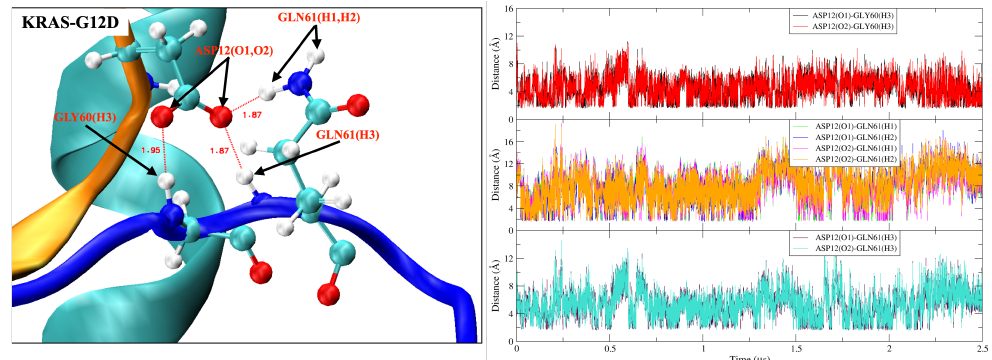
Figure A5. Hydrogen bond interactions between KRAS-G12D ASP12 residue and amino acid residues (GLY60, GLN61) of SW-II domain. ( Left ) Representative snapshot of HB ASP 12 ( O 1/ O 2 ) − GLY 60 ( H 3 ) , HB ASP 12 ( O 1/ O 2 ) − GLN 61 ( H 1/ H 2 ) and HB ASP 12 ( O 1/ O 2 ) − GLN 61 ( H 3 ) ; ( Right ) time evolution of atom–atom distance d ( t ) corresponding to the ( Left ) figure.